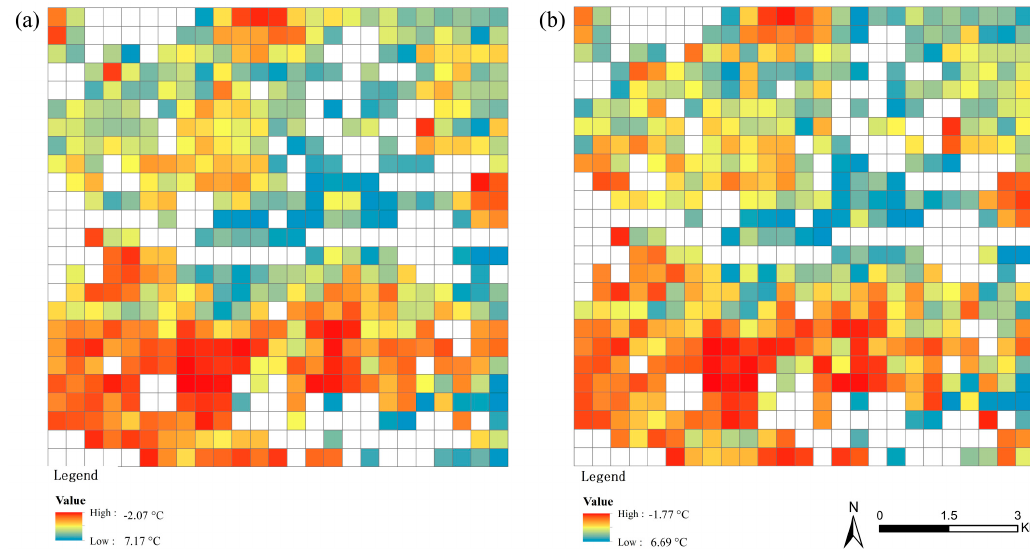
Figure 11. The consistency of ( a ) Observed and ( b ) Predicted SUHI images for both LCZs 1–5 and the mixed LCZ; the white grids are neither LCZs 1–5 nor mixed LCZ.